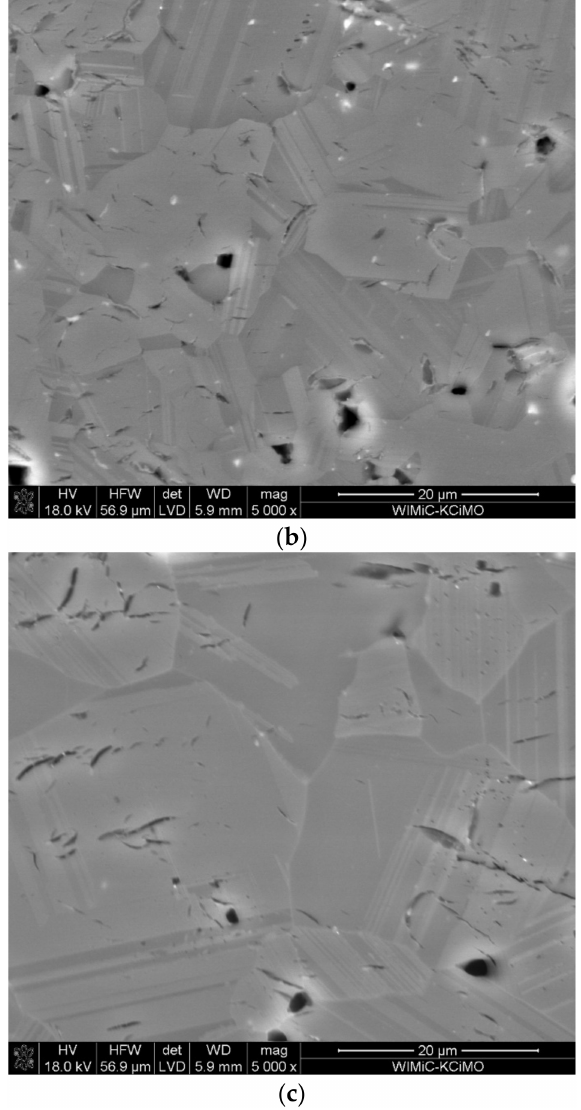
Figure 9. SEM micrographs of sinters made from mixtures with different starting compositions that were reaction sintered at 1900 ◦ C: ( a ) B:C = 5:1; ( b ) B:C = 10:1; and ( c ) B:C =